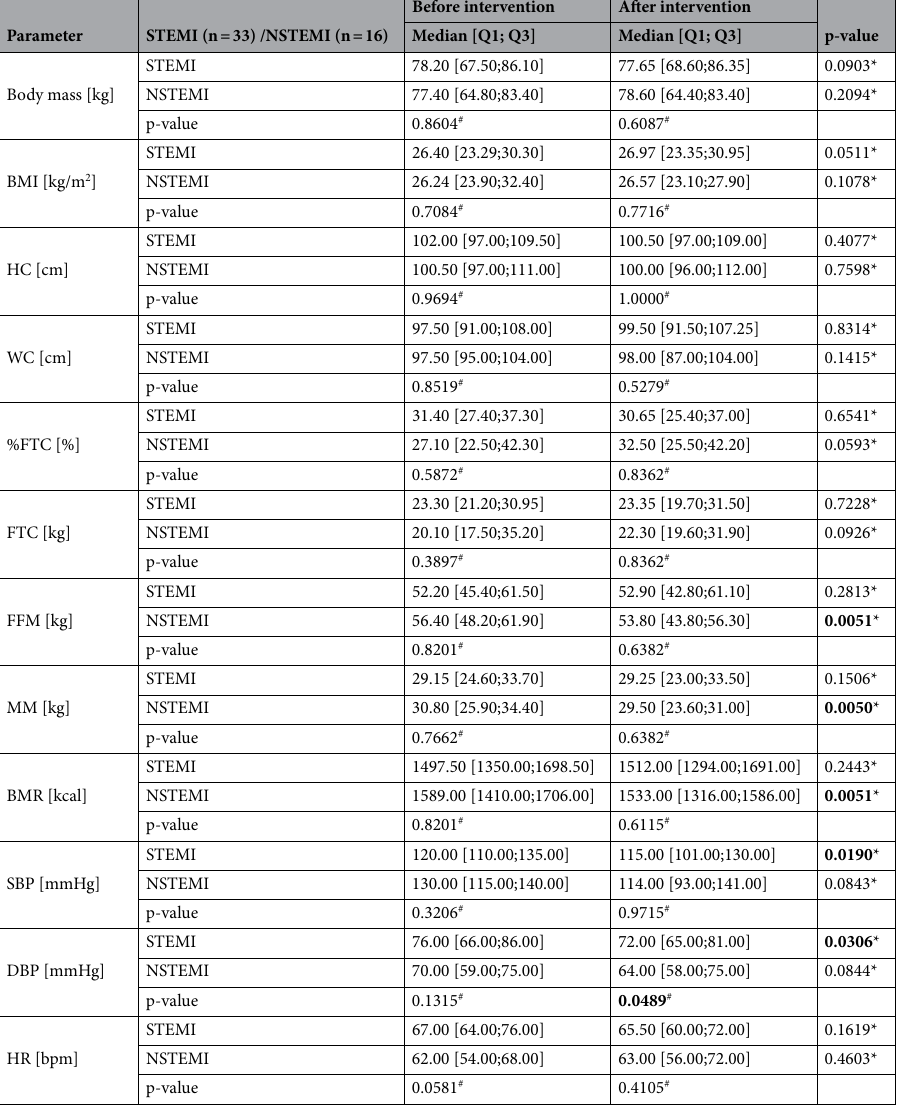
[Q1; Q3]. %FTC: percentage fat tissue content; BMI: body mass index; BMR: basal metabolic rate; bpm: beats per minute; DBP: resting diastolic blood pressure; FFM: fat-free mass; FTC: mass fat tissue content; HC: hip circumference; HR: resting heart rate; MM: muscle mass; NSTEMI: non-ST-segment elevation myocardial infarction; Q1: first quartile; Q3: third quartile; SBP: resting systolic blood pressure; STEMI: ST-segment elevation myocardial infarction; WC: waist circumference. *Wilcoxon test; # Mann–Whitney test. Significant values are given in